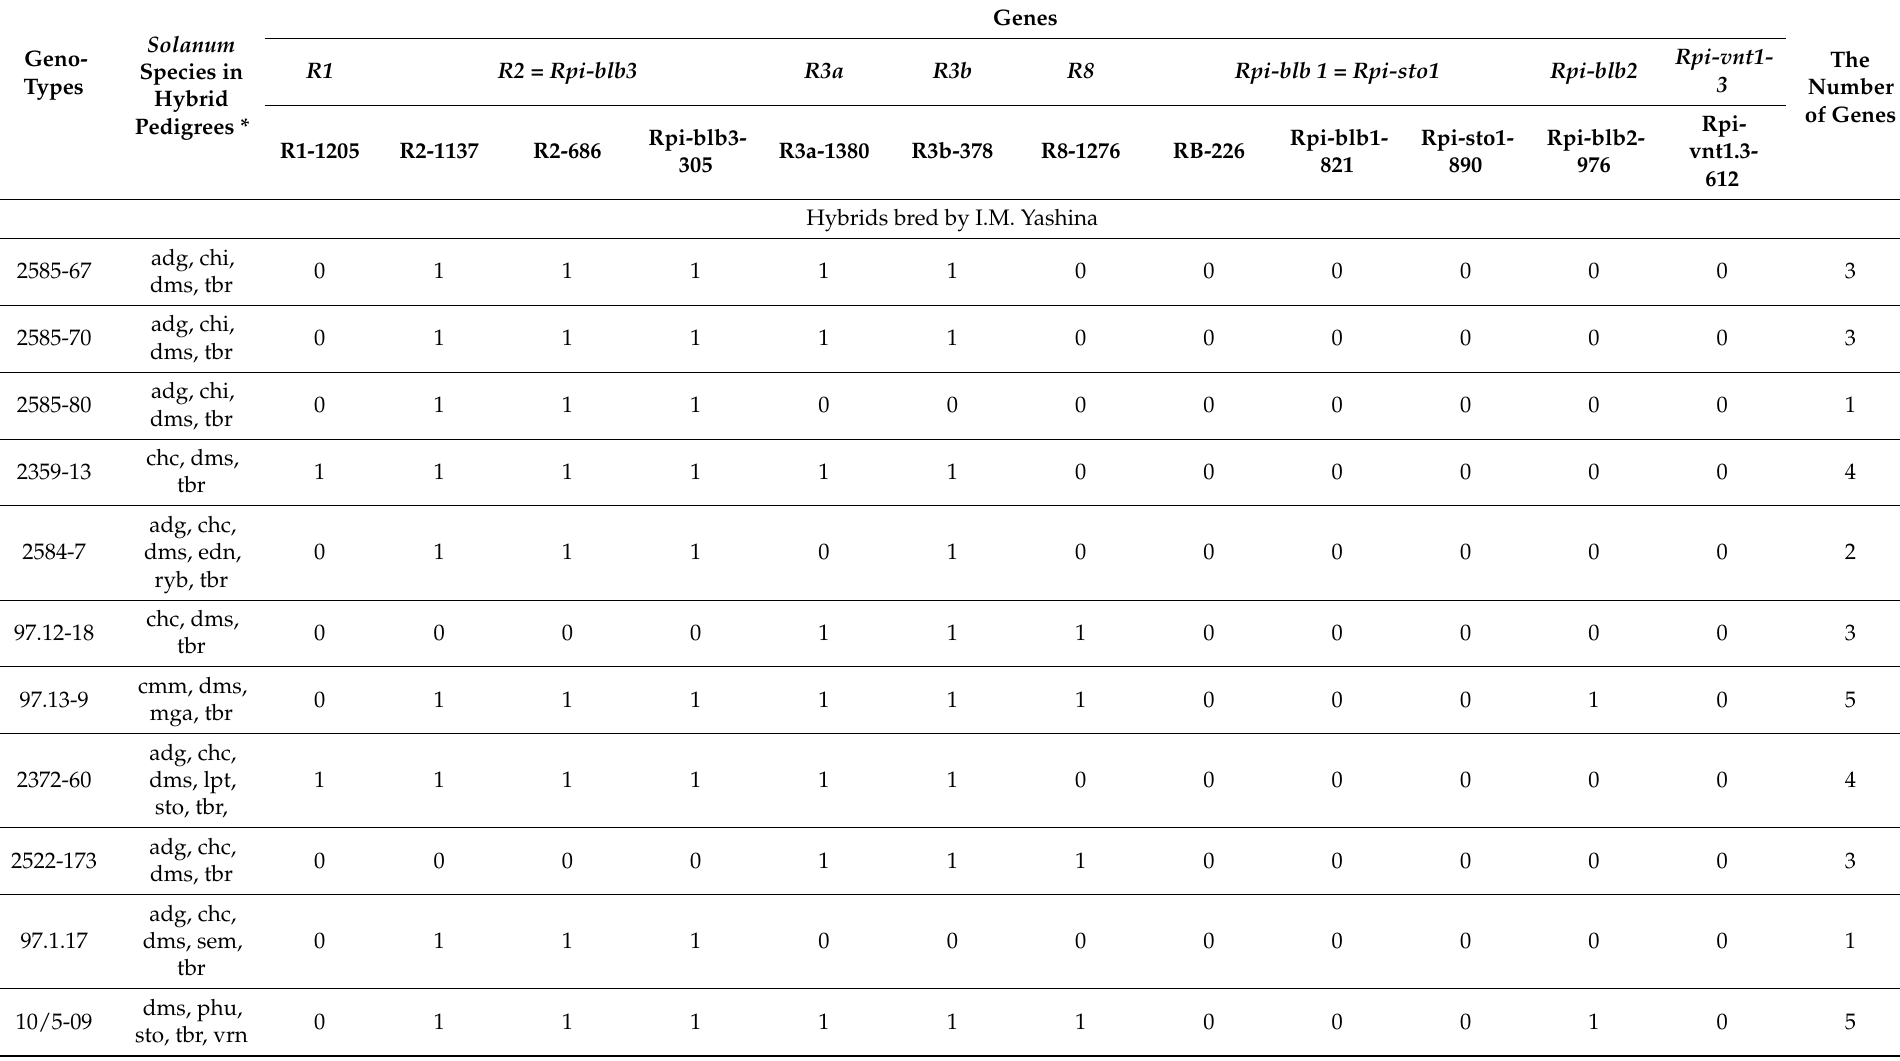
Table 4. Markers of Rpi genes in multiparental interspecific hybrids and reference potato cultivars (1/0—presence/absence of